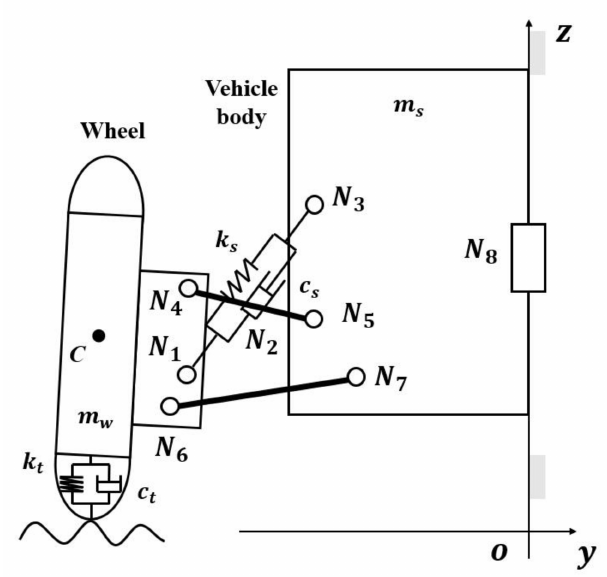
Figure 4. Quarter-vehicle model with a double-wishbone